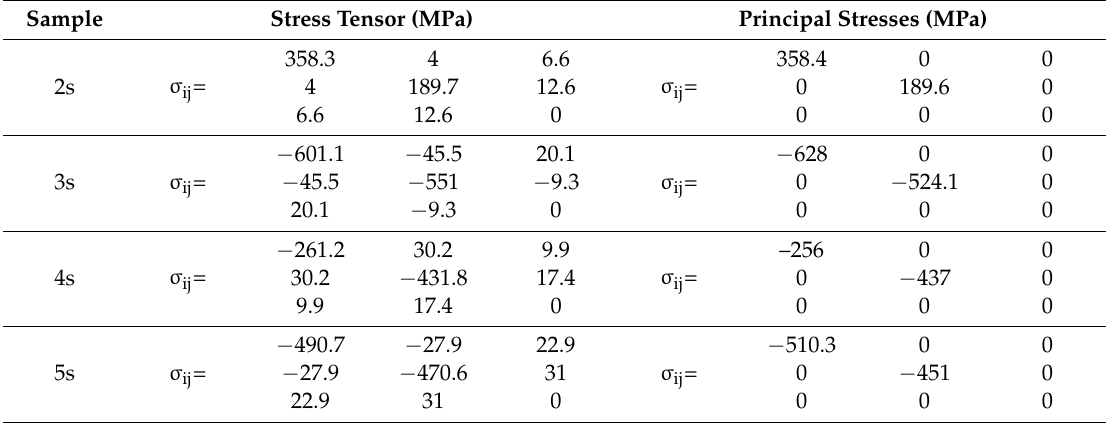
Table 4. Biaxial analysis showing the stress tensor and principal stresses.